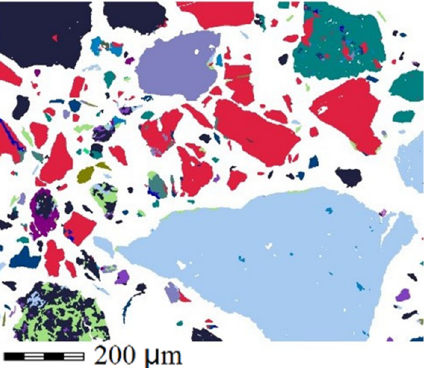
Figure 6. Distribution of sulfide minerals in the lead–zinc mine (red part).